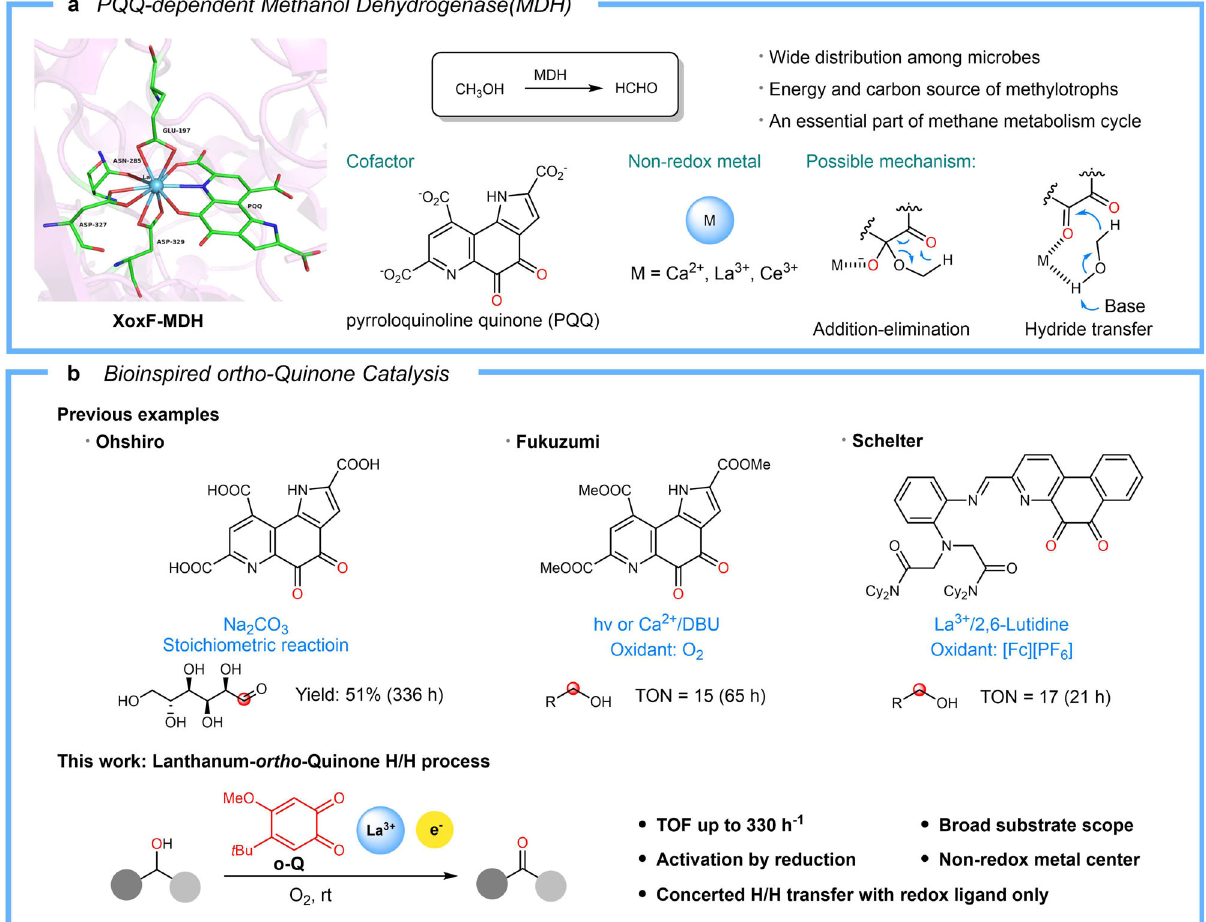
Fig. 1 Aerobic oxidation of alcohols. a Left: active sites of XoxF-methanol dehydrogenase (La-MDH) (PDB ID: 6adm). Right: overview of methanol dehydrogenase. b Bio-inspired ortho -quinone catalysis. Upper: previous reports about redox properties of PQQ model compounds. Lower: overview of this